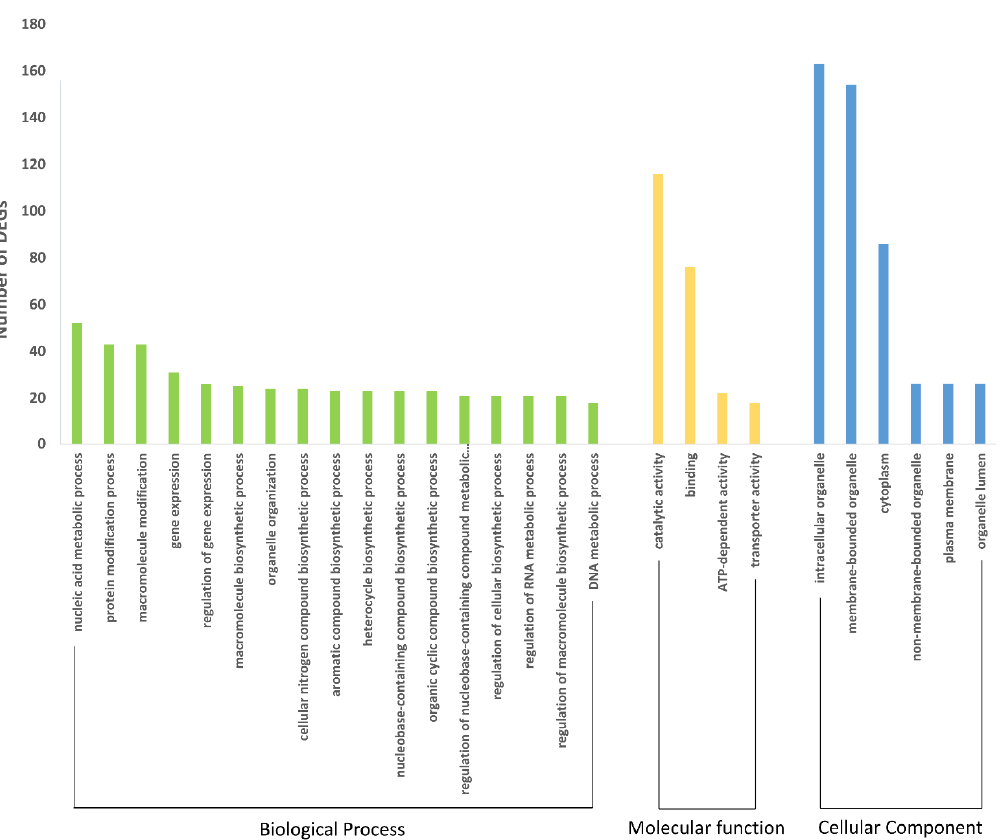
Figure 3. Gene ontology terms identified for DEGs in both treatments. Each color represent one main category: green for biological process, yellow for molecular function, and blue for cellular components. In the x axis the GO terms are represented. Table 3. Selection of up- and down-regulated genes of treatments with a possible relation to the aging of A. fraxinifolium seeds. ID